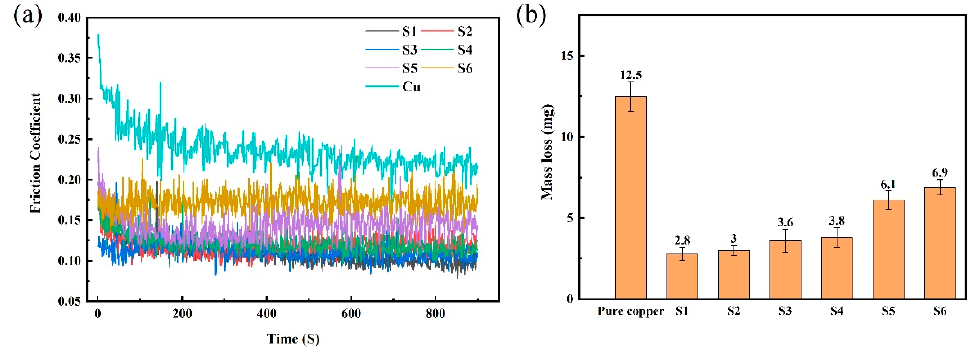
Figure 12. Wear test results of pure copper and Ni60A coatings (S1–S6): ( a ) friction coefficient and ( b ) mass loss.